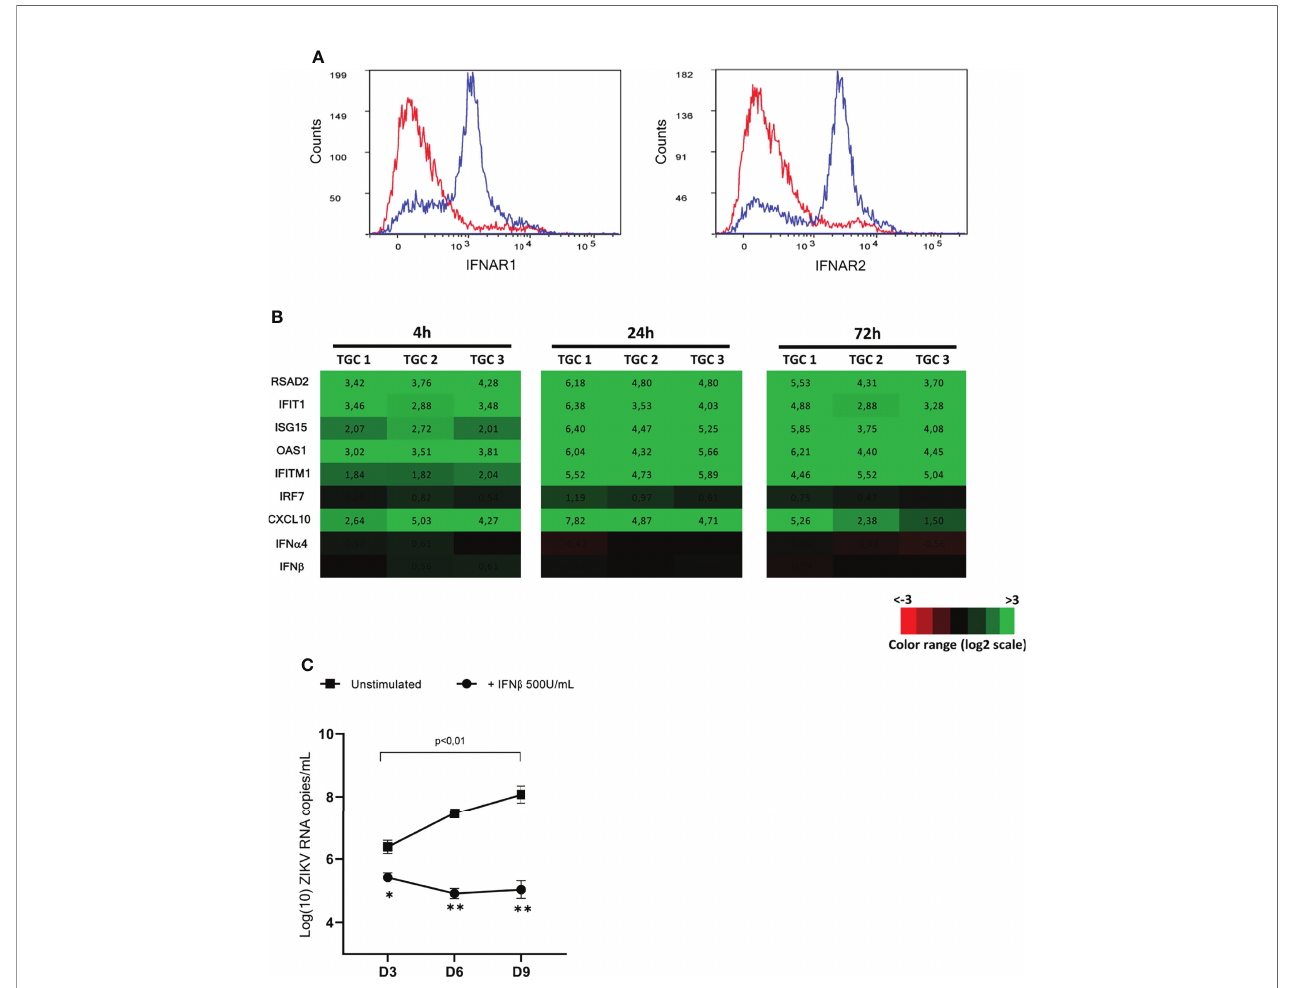
FIGURE 7 | Responsiveness of isolated TGCs and ZIKV-infected human explants to exogeneous IFN b . (A) Flow cytometry cell surface expression of the two IFN type I receptor subunits (IFNAR1 and IFNAR2) on DDX4+ human testicular germ cells using speci fi c antibodies (blue line histogramm). The speci fi city of detection was ensured using corresponding isotypes as controls (red line histogramm). (B) Isolated primary human testicular germ cells from 3 donors were stimulated with IFN b 200U/mL for 4 and 72h. Innate immune gene expression was determined by RTqPCR. Heatmap show log2 – transformed expression ratios of genes expressed by IFN-stimulated TGCs and time-matched mock-infected TGCs. Green indicates upregulation and red downregulation of mRNA compared with unstimulated controls. (C) Human testis explants from 5 donors were inoculated overnight with ZIKV at TCI50 10 5 (MOI 1). After thorough washes, ZIKV infected explants were treated or not with recombinant IFN b (500U/mL) for 8h and then cultured on 12 wells-inserts with 1mL complete medium/well for 9 days. Culture media were fully removed and changed every 3 days until day 9. Each dot represents de novo viral release over 3-days culture periods determined by RT-qPCR on culture supernatants. Horizontal bars represent the mean values ± SEM. Friedman + Dunn non-parametric test and Mann-Whitney non-parametric test, **p=0,0079 *p=0,159 for paired comparison +/- IFN